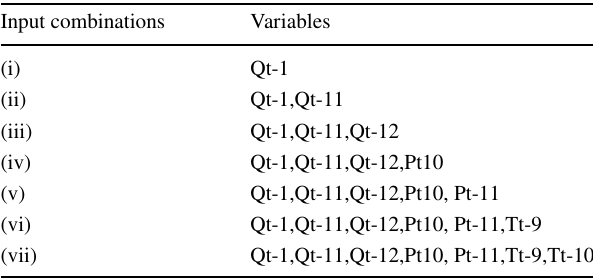
Table 2 The input combinations used for model